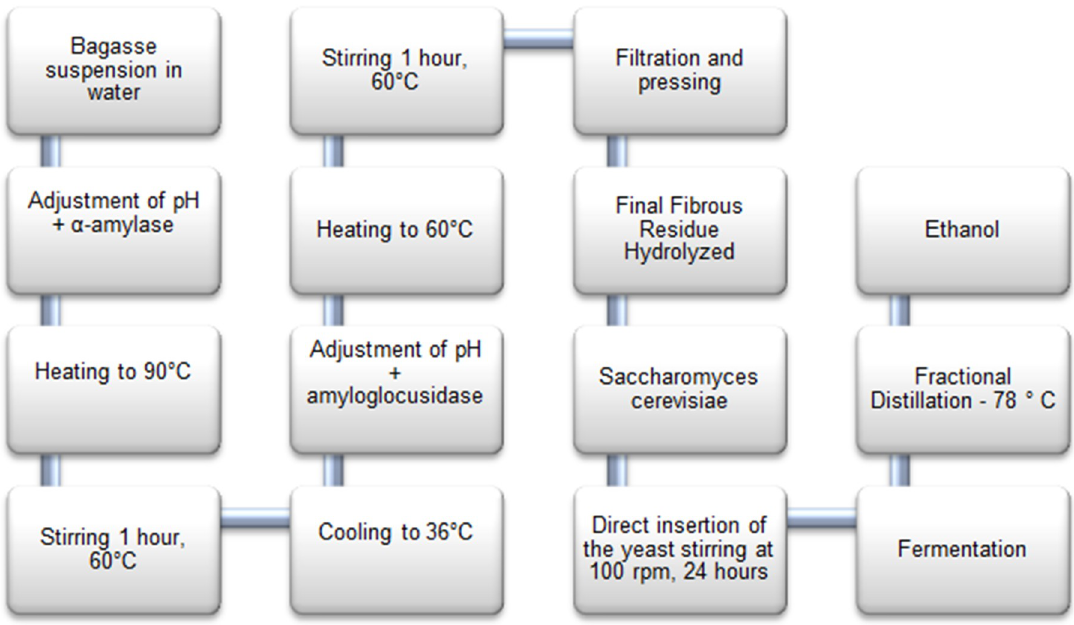
Figure 1. This represents systematically the process as a whole, for obtaining ethanol.